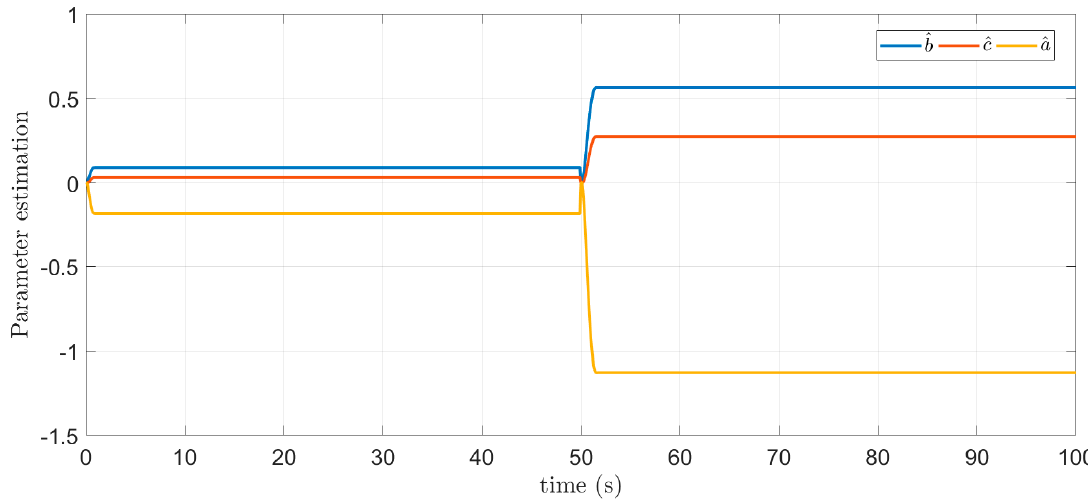
Figure 14. Simulation behavior of parameter adaptation.